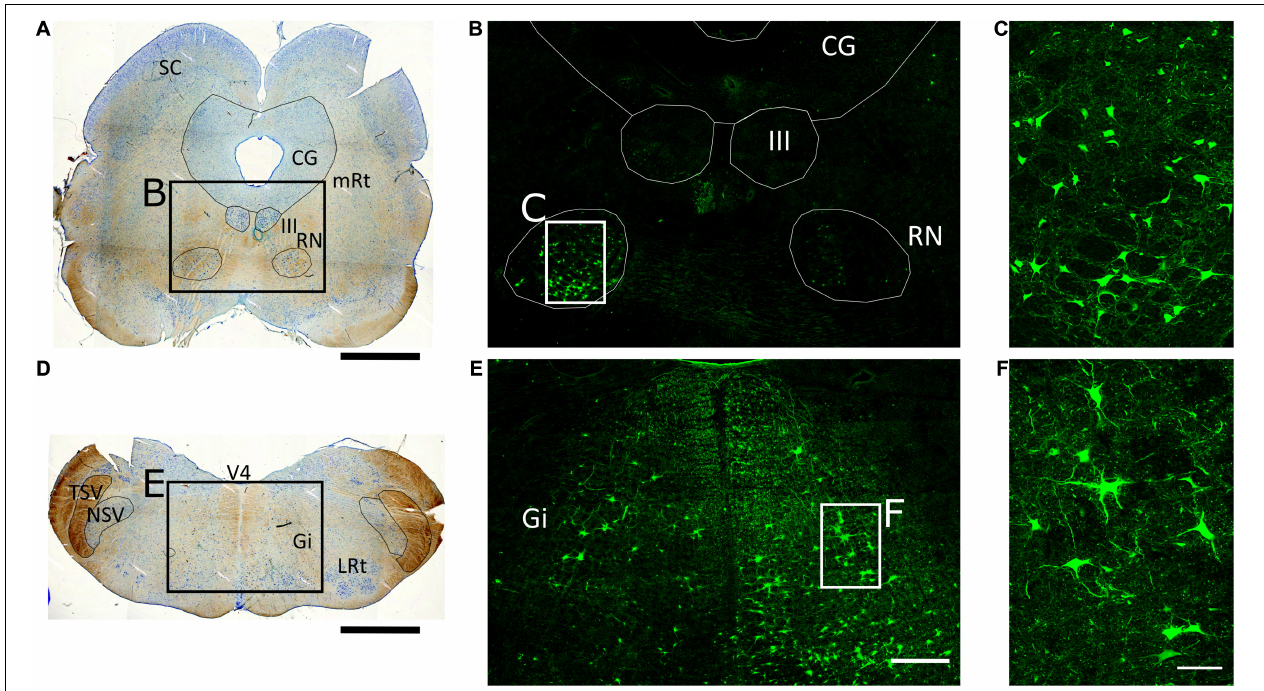
FIGURE 2 | Retrograde tracing of brainstem nuclei projecting to the spinal cord. (A,D) 50- µ m thick tissue sections of the porcine midbrain and medulla oblongata stained with Toluidine blue to identify brainstem structures. SC, Superior colliculus; CG, central gray; mRt, mesencephalic reticular formation; III, oculomotor nucleus; RN, red nucleus; V4, fourth ventricle; TSV, spinal trigeminal tract; NSV, spinal trigeminal nucleus; Gi, gigantocellular reticular nucleus; LRt, lateral reticular formation. Scale bar, 4 mm. (B,E) Mosaic images of midbrain and medulla oblongata, respectively, from tissue sections adjacent to those shown in (A,D) , captured at 10X with an Olympus IX83 microscope. Numerous aminostilbamidine-labeled neurons are observed in the magnocellular part of the contralateral RN, and the ipsilateral Gi. Scale bar, 1 mm. (C,F) Confocal fluorescence images of the regions in rectangles in (B,E) , showing neurons labeled in the contralateral RN and ipsilateral Gi at higher magnification. Scale bar, 200 µ